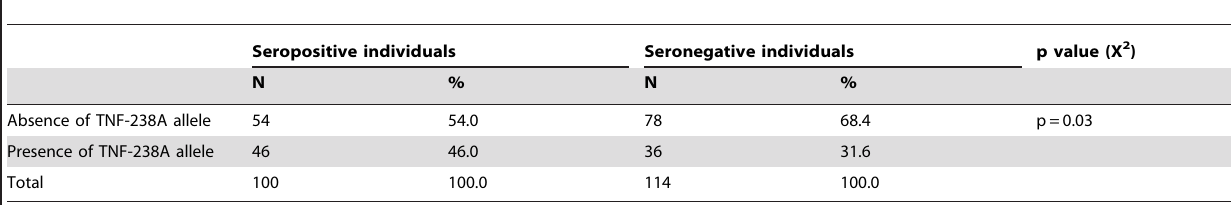
Table 2. Presence and absence of the TNF-238A allele in seropositive and seronegative individuals.